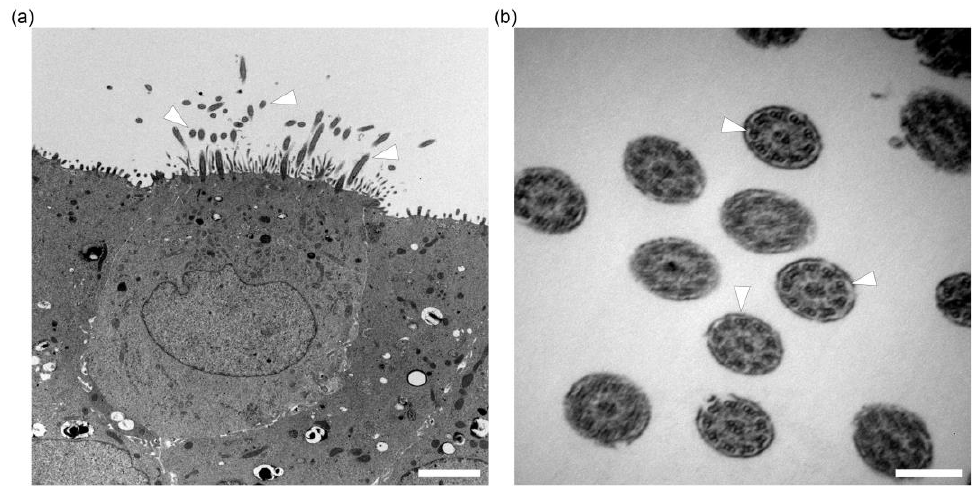
Figure 6. Ultra-structural analysis of cilia formation in differentiated tracheal epithelial cells under air–liquid interface (ALI) conditions. ( a ) Representative image of an ALI culture at day 21 with fully developed cilia (arrowheads). Cilia show longitudinal and unidirectional growth varying in length and diameter with basal bodies. Scale bar represents 2500 nm. ( b ) Higher magnification (scale bar represents 250 nm) of cilia in cross sections with 9 + 2 axoneme arrangement (arrowheads) within cilia membrane.